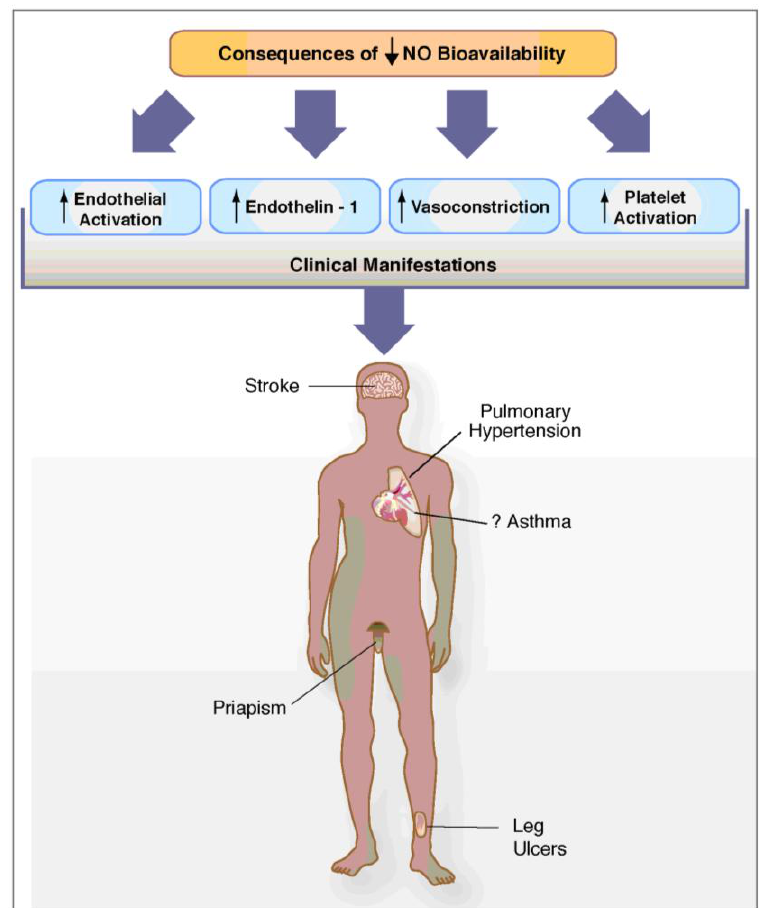
FIGURE 2. Consequences of low NO bioavailability. The consequences of decreased NO bioavailability include endothelial cell activation, up- regulation of the potent vasoconstrictor endothelin-1, vasoconstriction, platelet activation, increased tissue factor, and activation of coagulation pathways, all of which ultimately translate into the clinical manifestations of SCD. NO bioavailability is particularly vulnerable to the effects of hemolysis, an event in SCD that contributes to the development of the hemolytic subphenotypes[69], which include pulmonary hypertension, priapism, cutaneous leg ulceration, stroke, and possibly asthma. (Reproduced with permission from the American Society of